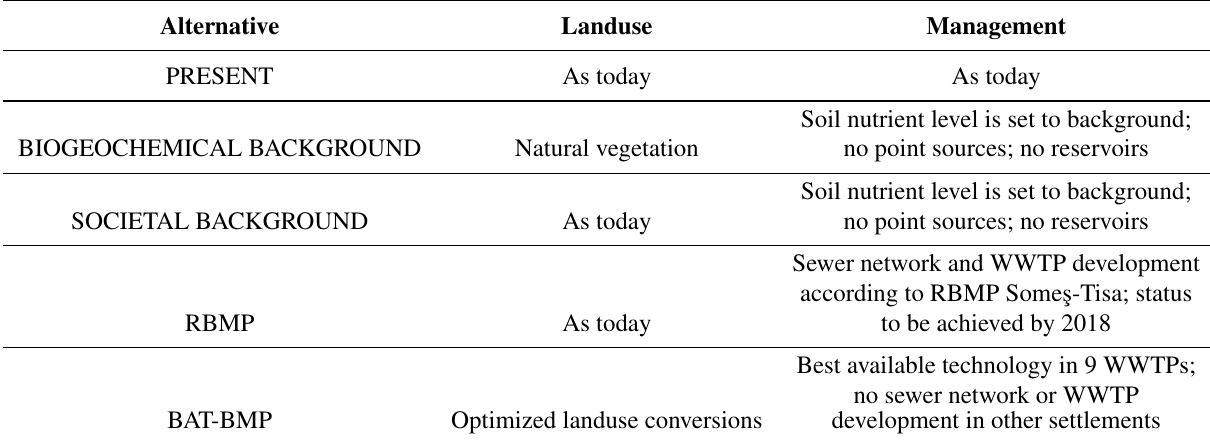
Table 1. Alternatives for landuse and